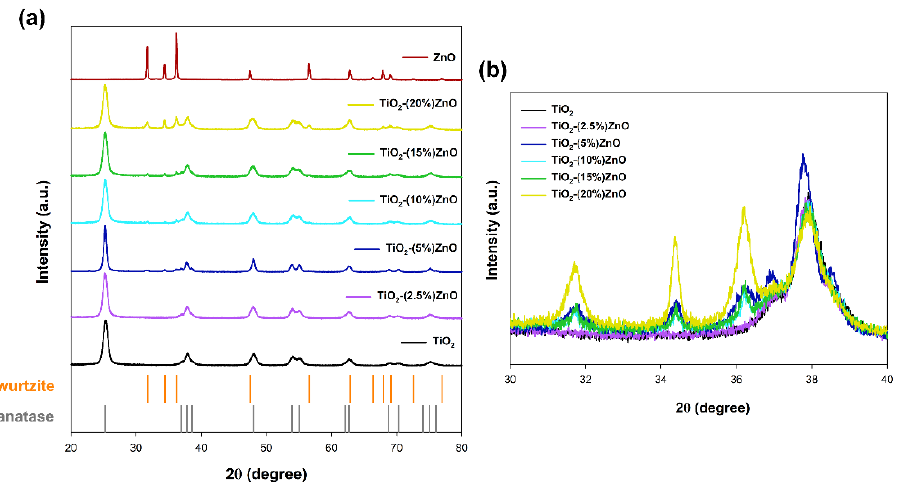
Figure 4. The XRD patterns ( a ) and focus on 2 θ = 30–40° ( b ) for TiO 2 -ZnO systems and reference